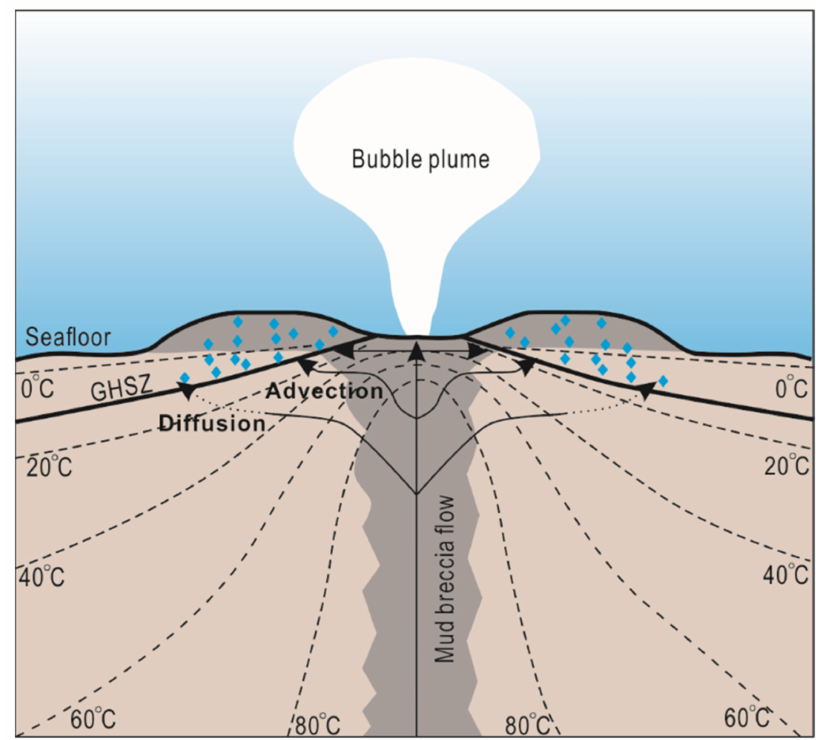
Figure 25. Distribution of gas hydrates superimposed on a schematic model of the temperature field in the Håkon Mosby MV. The GHSZ (bold lines) largely depends on the P-T conditions. Hydrate accumulation is determined by both the thermal gradient and the gas fluxes. Methane is oxidized by sulfate via the downward flow of seawater, leading to a gradually deeper sulfate–methane interface toward the margins (modified from